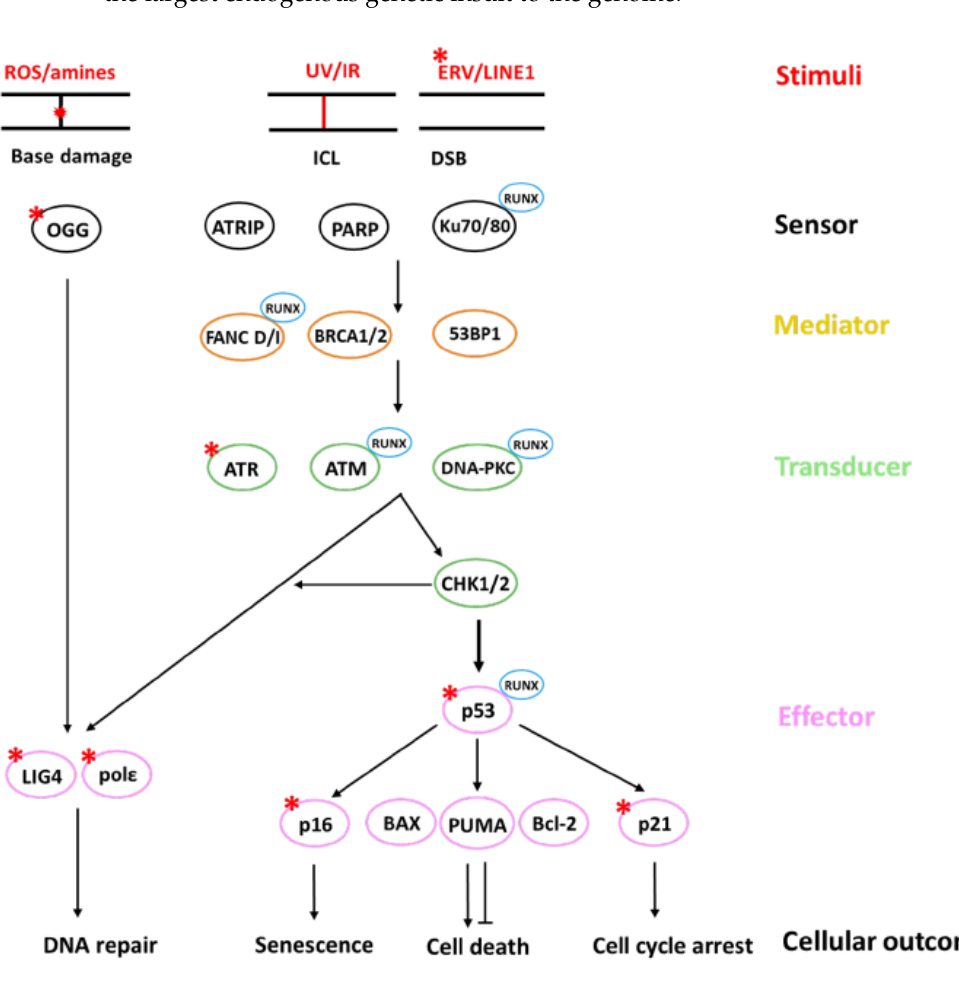
Figure 1. Involvement of the RUNX family in DNA repair pathways. In the scenario where a cell encounters DNA damage, the cell decides on the specific DNA repair pathway responsible for that damage. The DNA repair process is broadly divided into 5 stages: stimulus response, damage sen- sor, signal transducer, and mediators that provide binding of different factors and effectors. Based on the extent of the damage, the DNA might be repaired or, otherwise, the cell is fated toward apoptosis or senescence. RUNX proteins are involved in every one of these stages, from the regula- tion of endogenous damaging agents such as ROS and endogenous retrovirus elements (ERV/LINE- 1) to the mediation of cell fate by interacting with p53 and its downstream genes. RUNX proteins regulate the DNA repair machinery either by interacting directly with the participating proteins or through transcriptional regulation. DNA repair factors that are transcriptionally regulated by RUNX1 are marked with a red asterisk. Abbreviations: ROS, reactive oxygen species; UV, ultraviolet; IR, ionizing radiation; ERV, endogenous retrovirus; ICL, inter-strand cross link; DSB, double-strand break.